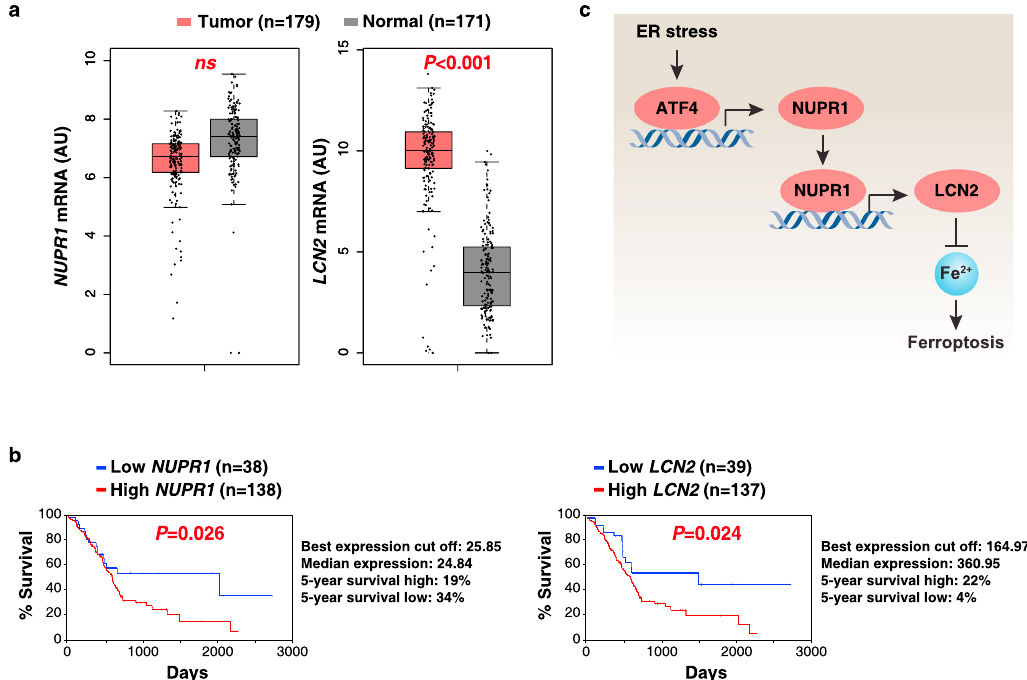
Fig. 7 Prognostic signi fi cance of the NUPR1 – LCN2 pathway in human PDAC. a Upregulation of LCN2 (but not NUPR1 ) gene expression within the tumor from PDAC patients compared to normal controls using datasets from the Cancer Genome Atlas (TCGA) (one-tailed t test). The data are presented as box-and-whisker plots. Boxes represent the median and the 25th and 75th percentiles. ns: not signi fi cant. n is number of cases. b Kaplan – Meier survival analysis of NUPR1 and LCN2 gene expression in PDAC patients using TCGA datasets (one-sided Log-rank [Mantel – Cox] test). n is number of cases. c Schematic representation of the role of NUPR1 in the regulation of ferroptosis in human PDAC